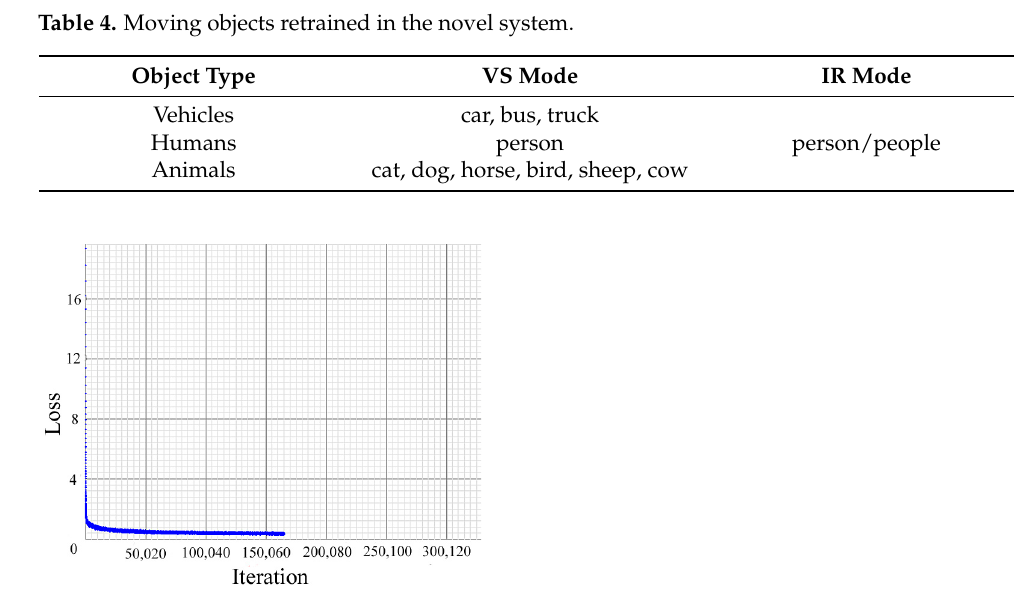
Figure 10. The relationship between loss and iteration during training.